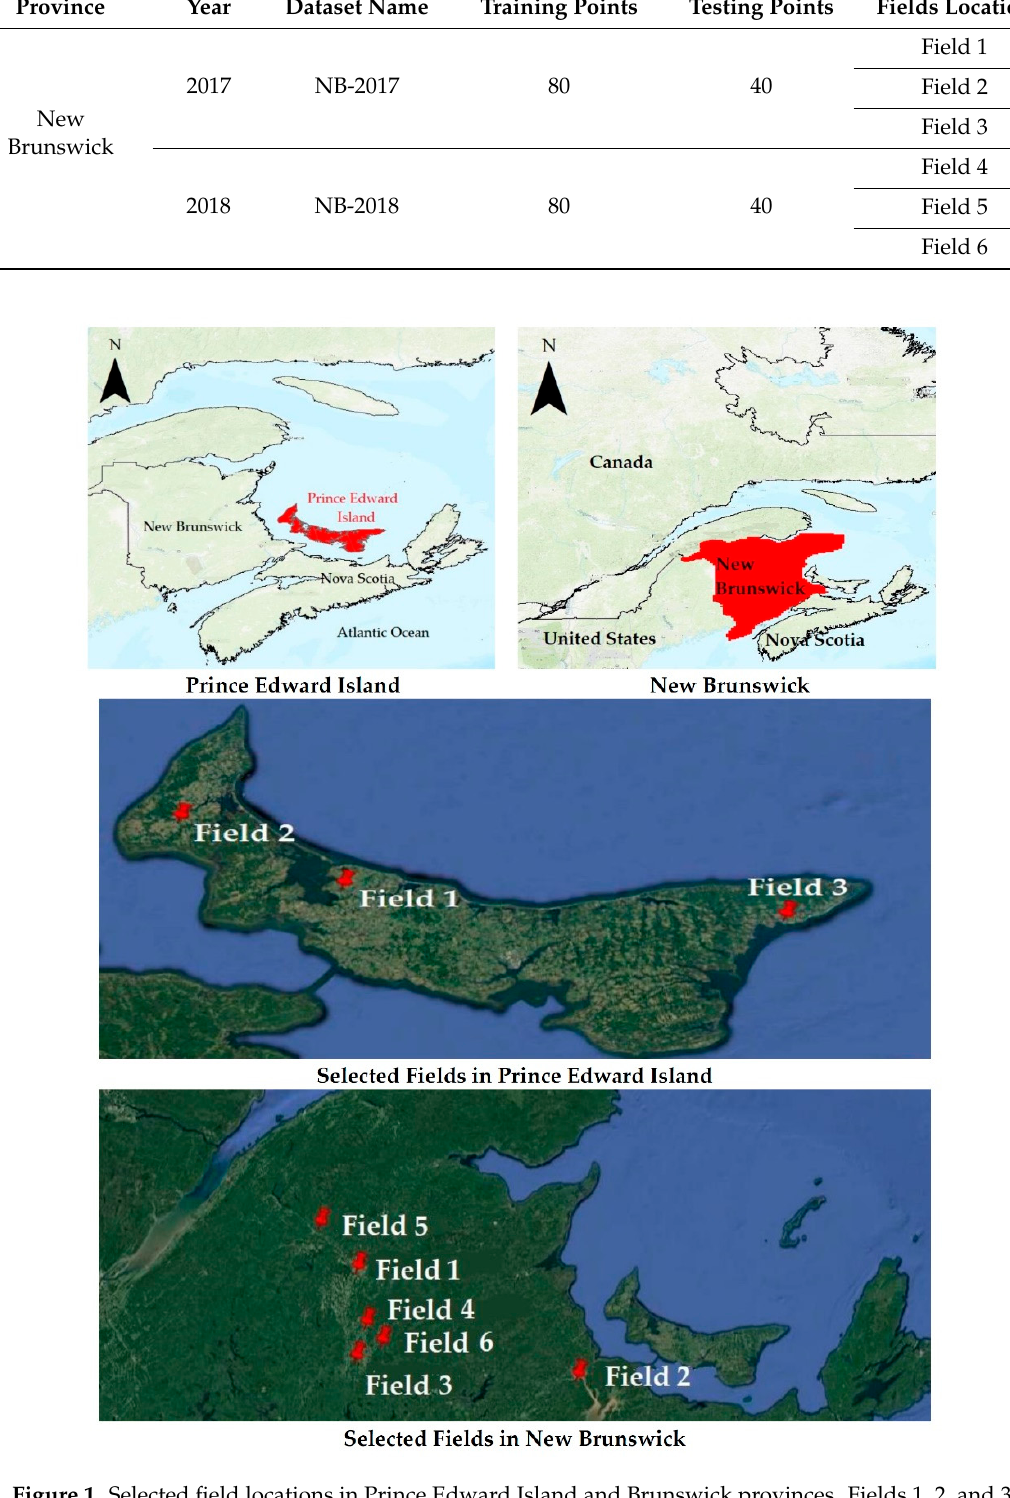
Figure 1. Selected field locations in Prince Edward Island and Brunswick provinces. Fields 1, 2, and 3 were in Prince Edward Island. Fields 1, 2, 3, 4, 5 and 6 were in New Brunswick.